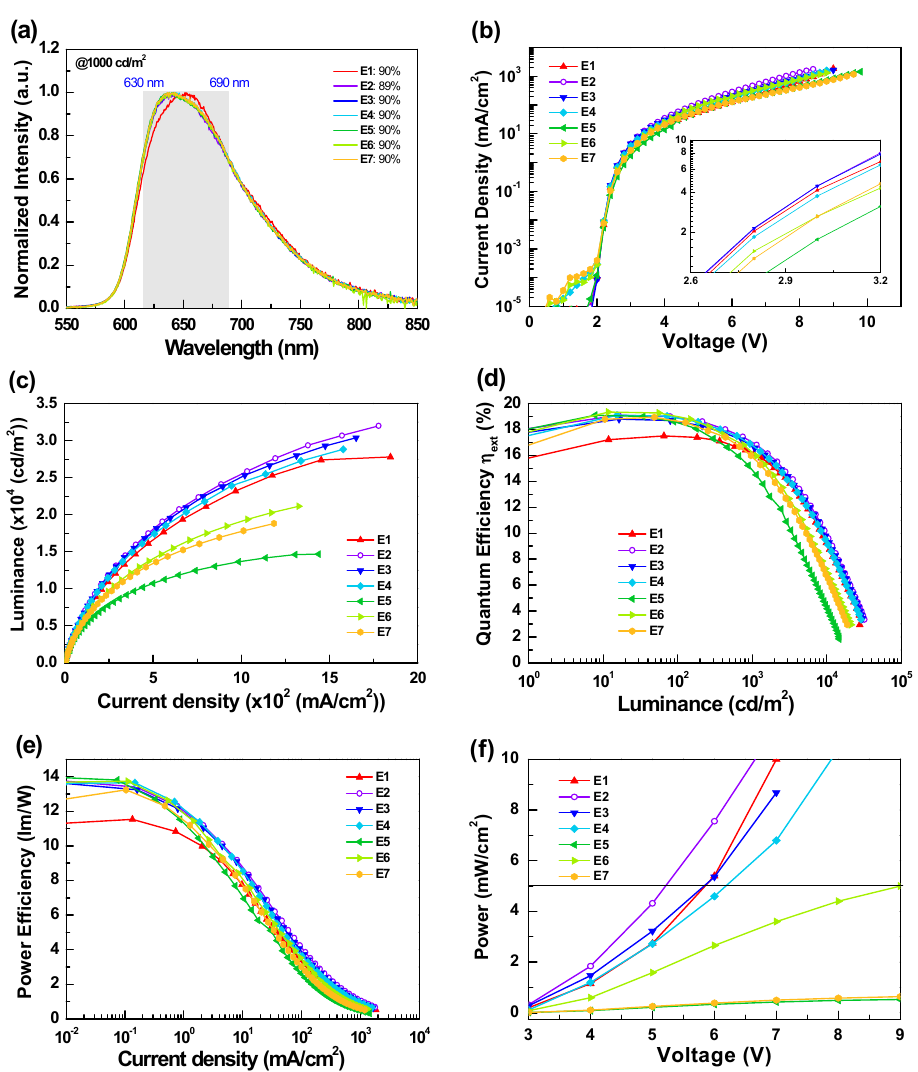
Figure 5. ( a ) Normalized EL spectra at a luminance of 10 3 cd/m 2 , ( b ) current density-voltage ( J - V ) characteristics, ( c ) luminance-current density ( L - J ) characteristics, ( d ) external quantum efficiency versus luminance, ( e ) power efficiency versus current density, ( f ) power density versus voltage for devices E1, E2, E3, E4, E5, E6, and E7.